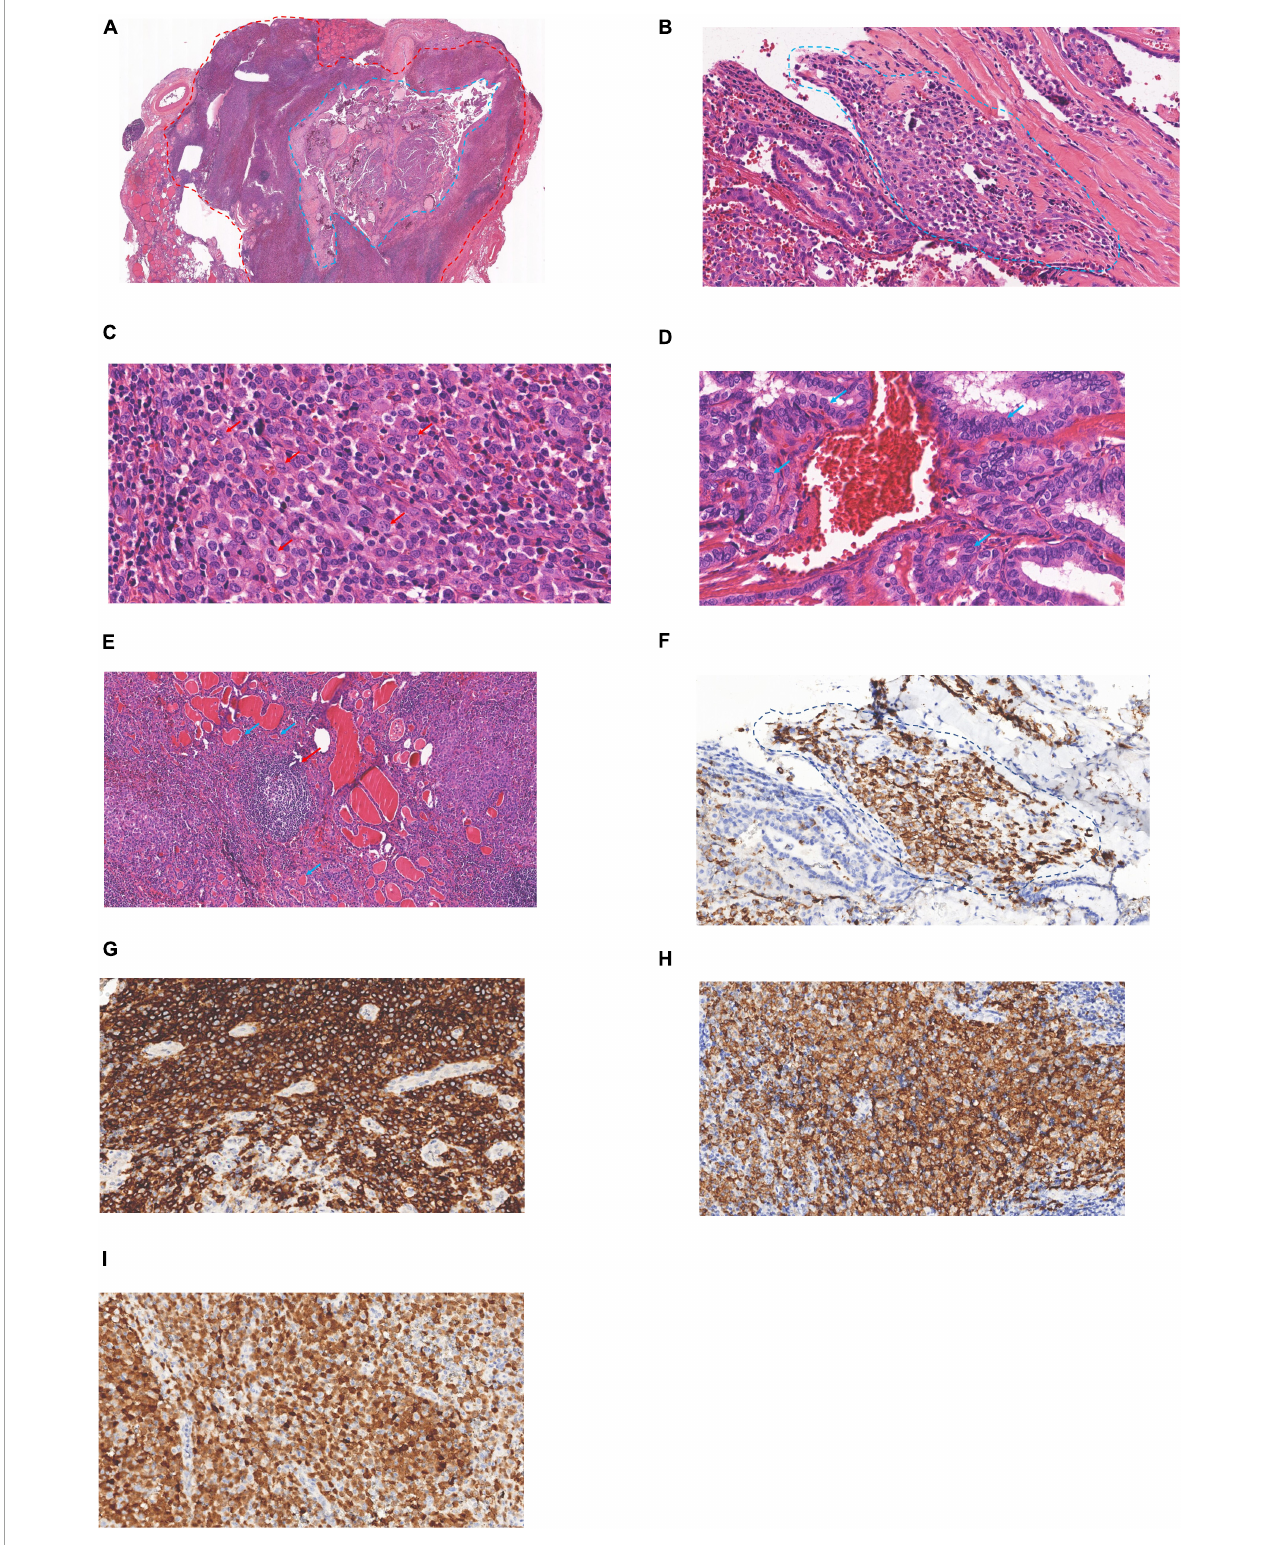
FIGURE2 Langerhans cell histiocytosis (LCH) of the thyroid concurrent with PTC: (A) PTC region (blue circle), LCH region (red circle, 1 × ). (B) Junctional zone between PCT and LCH (blue circle, 20 × ). (C) LCH region (red arrow, 40 × ). (D) PCT region (blue arrow, 40 × ). (E) Hashimoto’s thyroiditis, lymphoid follicle (red arrow), atrophic thyroid follicles (blue arrow) (10 × ). (F) Langerin (+) indicated that LCH cells were found in the stroma of PTC (blue circle, 20 × ). (G) CD1a cytoplasmic/membrane + (20 × ). (H) Langerin cell membrane + (20 × ), (I) S-100 nucleus/cytoplasm + (20 ×